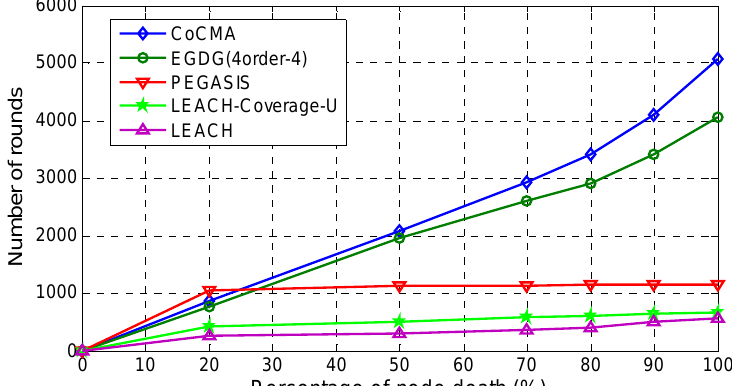
Figure 11. The number of rounds versus percentage of dead nodes (%) for the uniform deployment